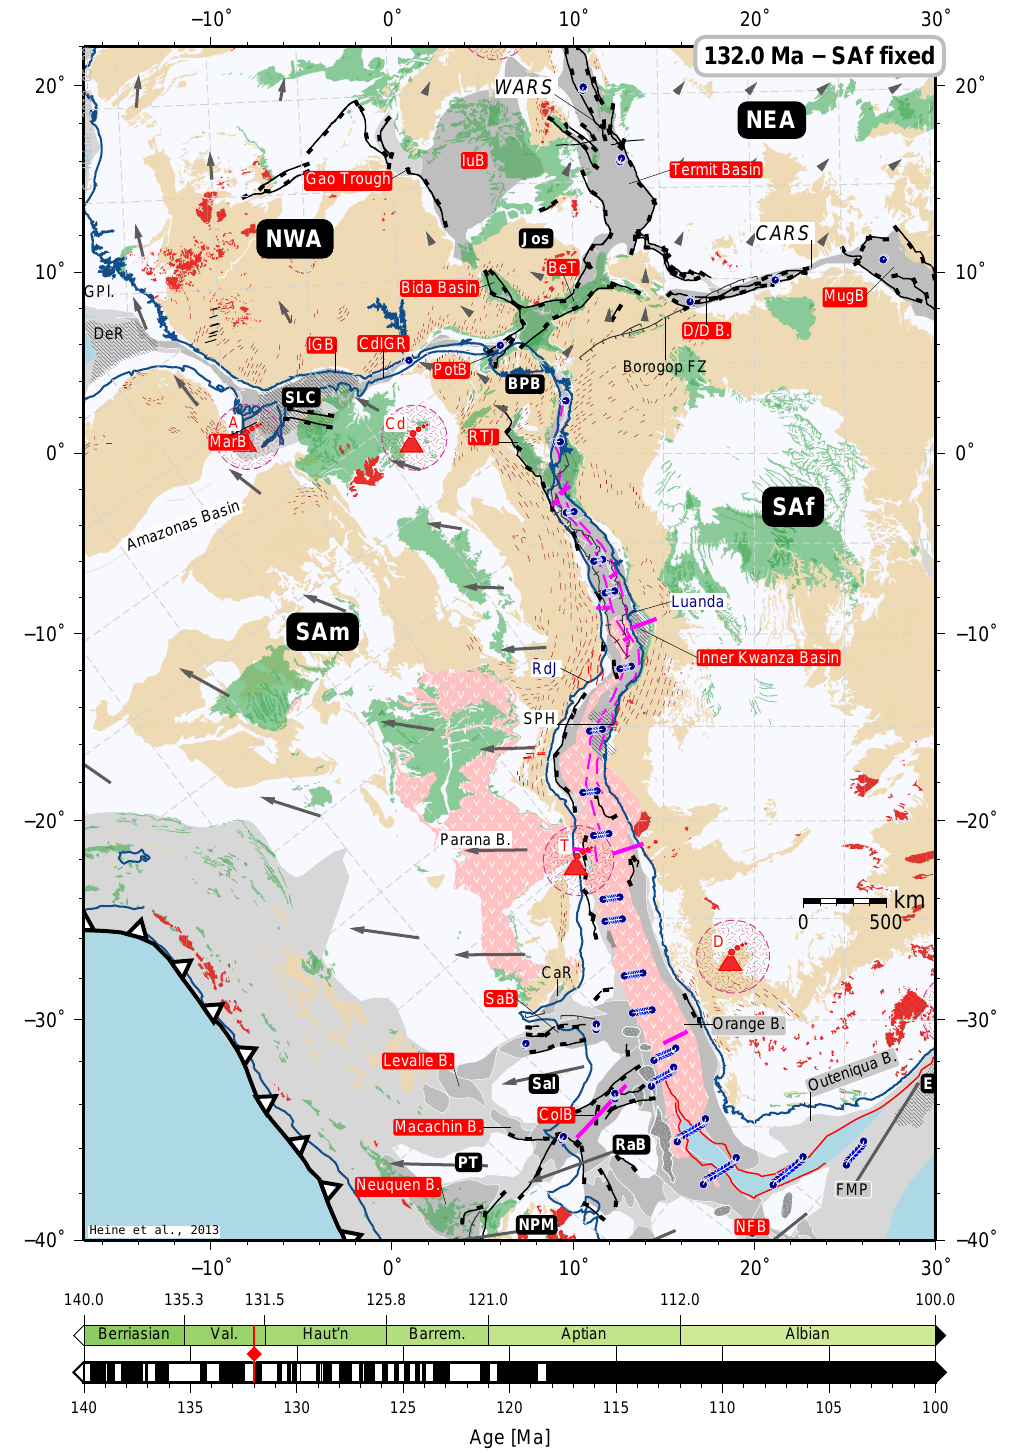
Fig. 16. Plate tectonic reconstruction at 132Ma, with Africa fixed in present-day coordinates. For map legend see Fig. 22, abbreviations as in Fig. 13. Note initial extension directions along the margin rotate from NW–SE in Gabon/Sergipe–Alagoas segment to W–E in Pelotas/Walvis Basin segment with increasing distance from stage pole location. Flowlines between Patagonian blocks in southern South America and southern austral Africa indicate and initial SW–NE directed motions between these plates (cf. Fig 11). In west Africa, the Iullemmeden and Bida basins as well as the Gao Trough are undergoing active extension. Tectonism along the equatorial Atlantic rift increases. Additional abbreviations: DGB – Deep Ghanaian Basin; CdIGR – Cˆote d’Ivoire/Ghana Ridge and associated marginal basins. Solid Earth, 4, 215–253,